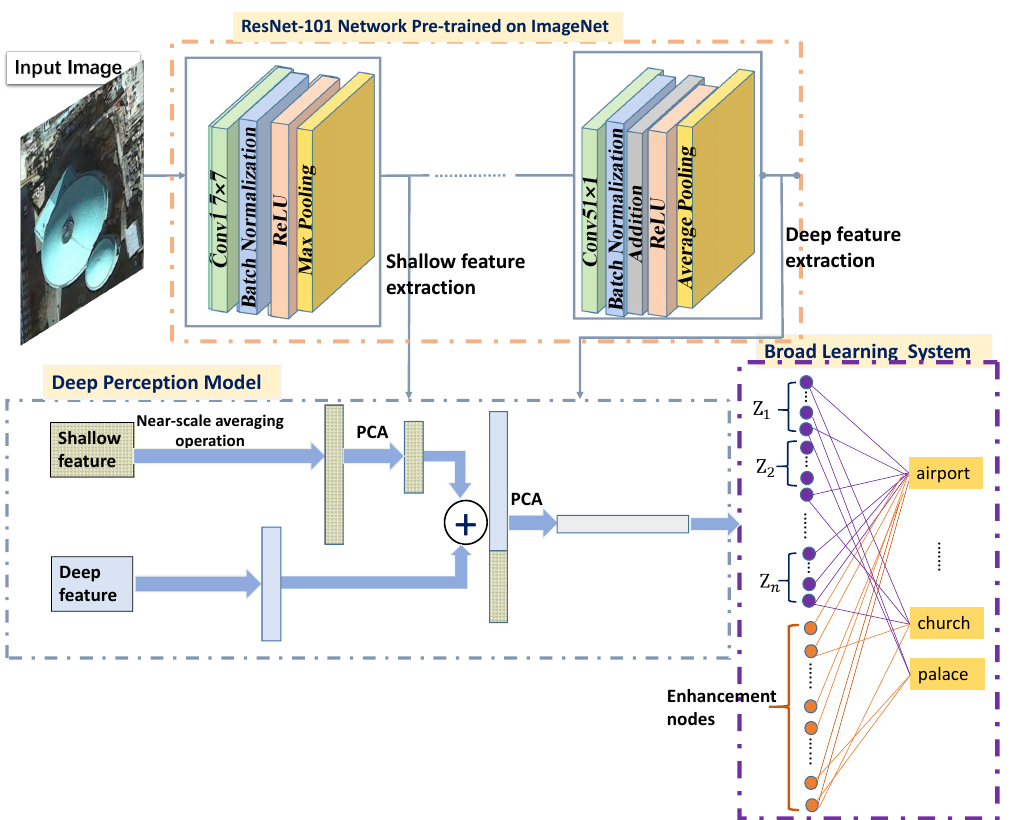
Figure 1. Framework of the proposed fast deep perception network